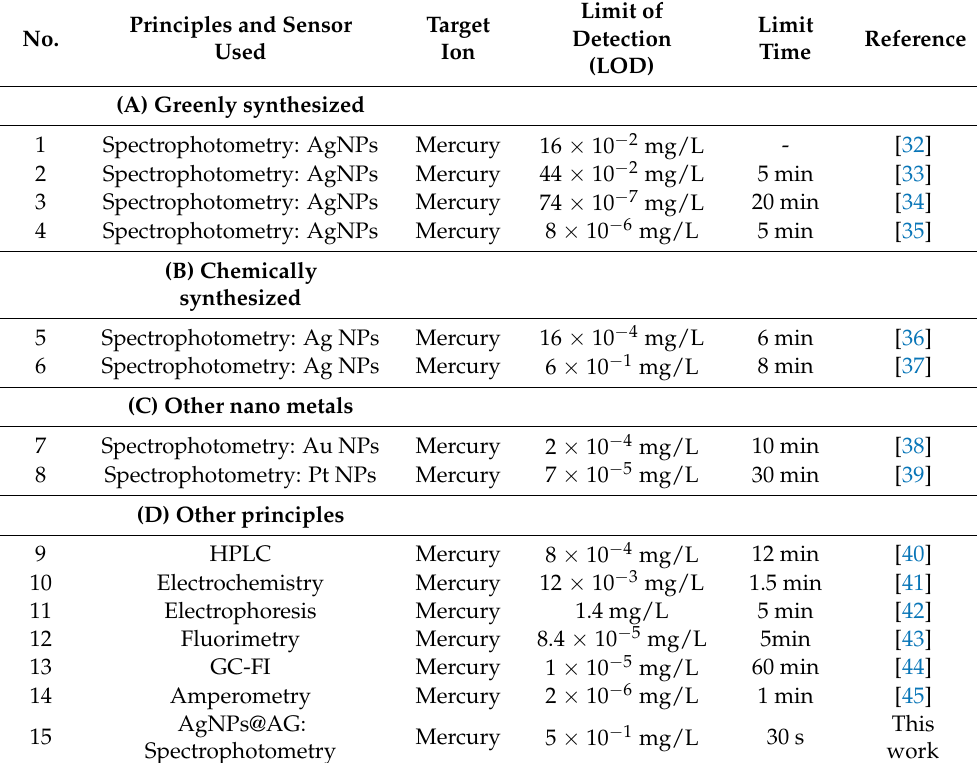
Table 1. Comparison of AgNPs@AG activity against detection of mercury (Hg 2+ ) with the previous published literature and